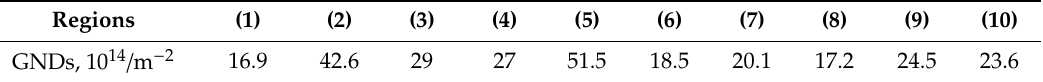
Figure 5. Kernel average misorientation (KAM) figure of scanning area and the local misorientation distribution map. Table 1. The calculated GNDs of ten subregions of (1–10) obtained by EBSD.